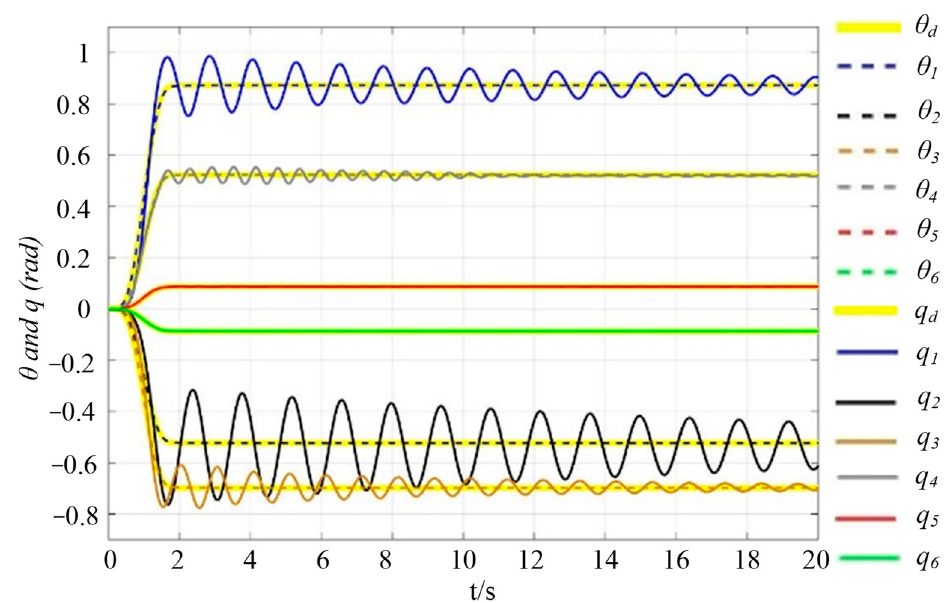
Figure 5. Motor- and link-side angular displacements with an elastic-torque feedback controller. (solid line: link side, dotted line: motor side).